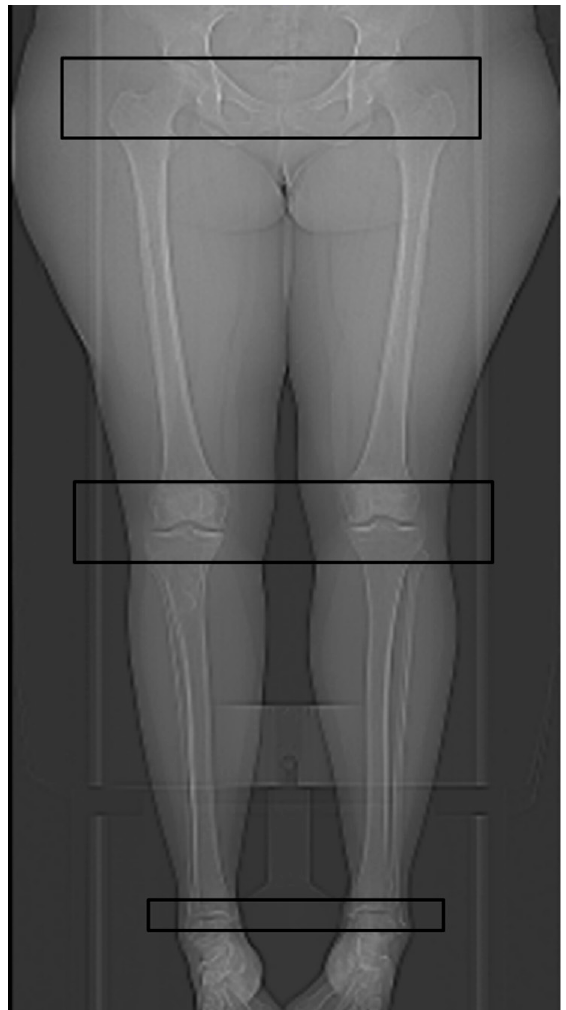
Figure 2. Anterior-posterior (AP) scout view with the marked scan length for the hip region, the knee region, and the ankle region according to the standard operating procedure (SOP) for the newly introduced ULD protocol for CT-torsion measurement of the lower limb.